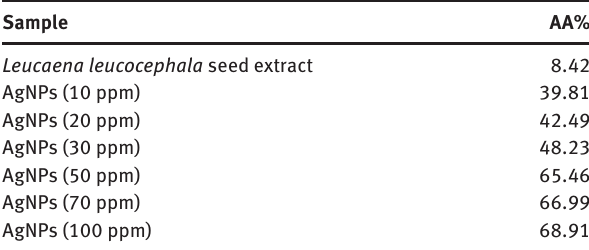
Table 2: Percentage antioxidant activity (AA%) of plant extract and silver nanoparticles